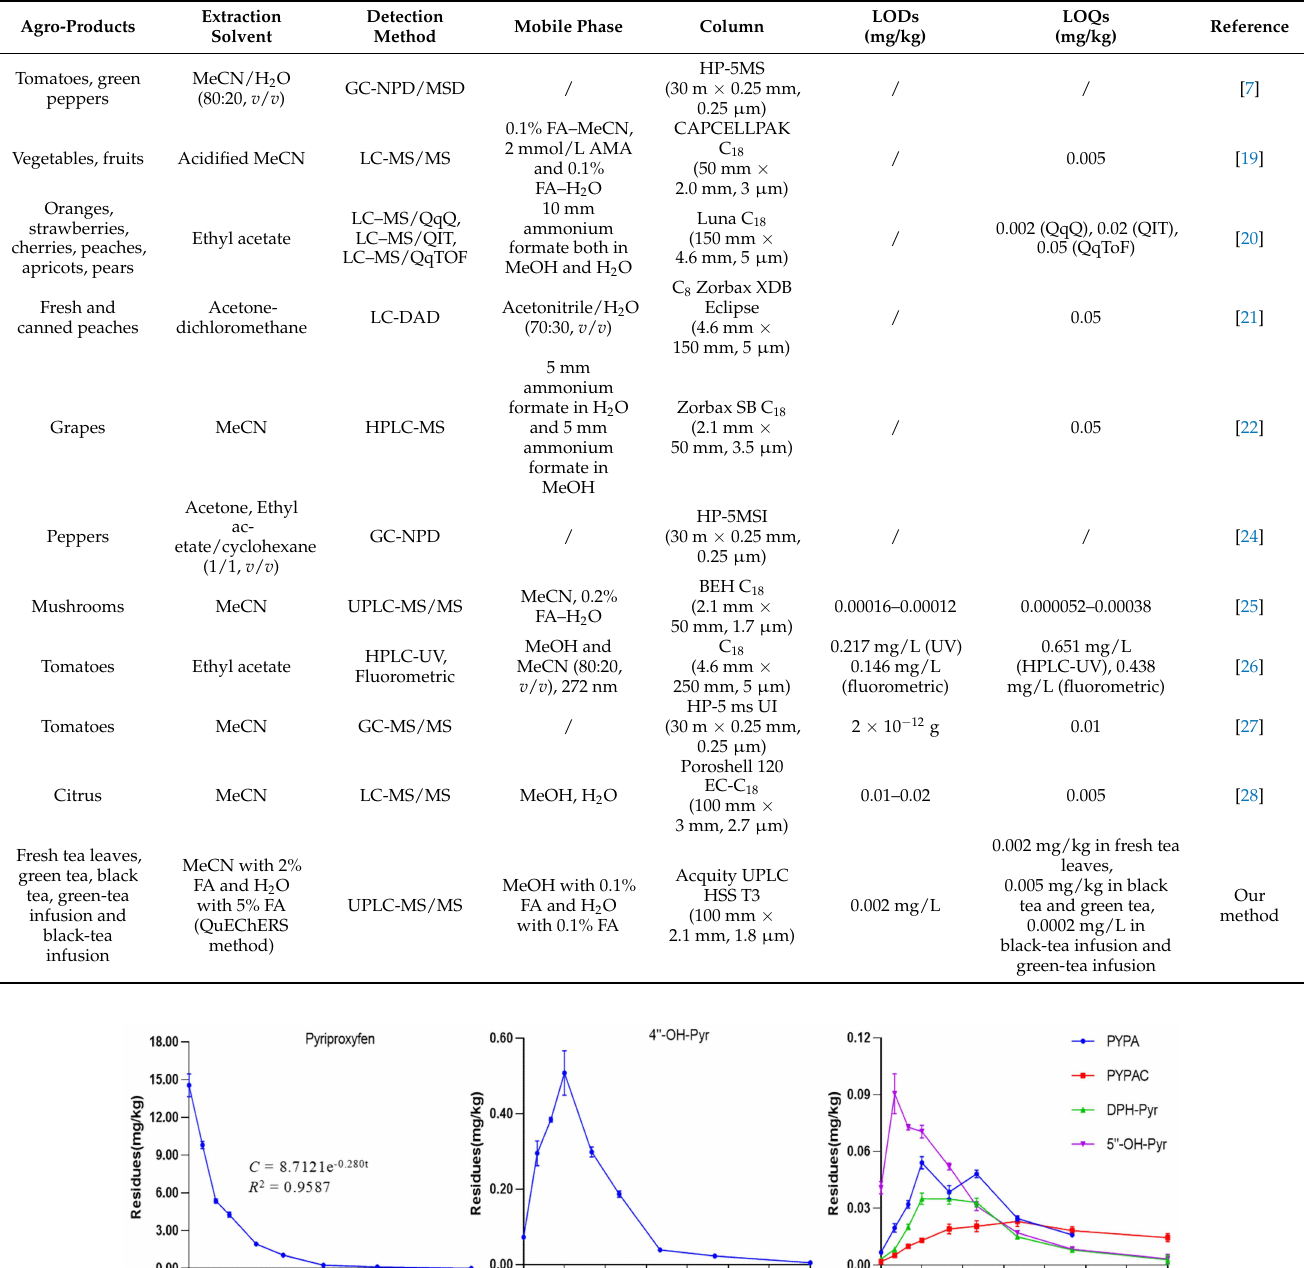
Table 3. Comparison of existing analytical methods in terms of pyriproxyfen residues on different agricultural products.